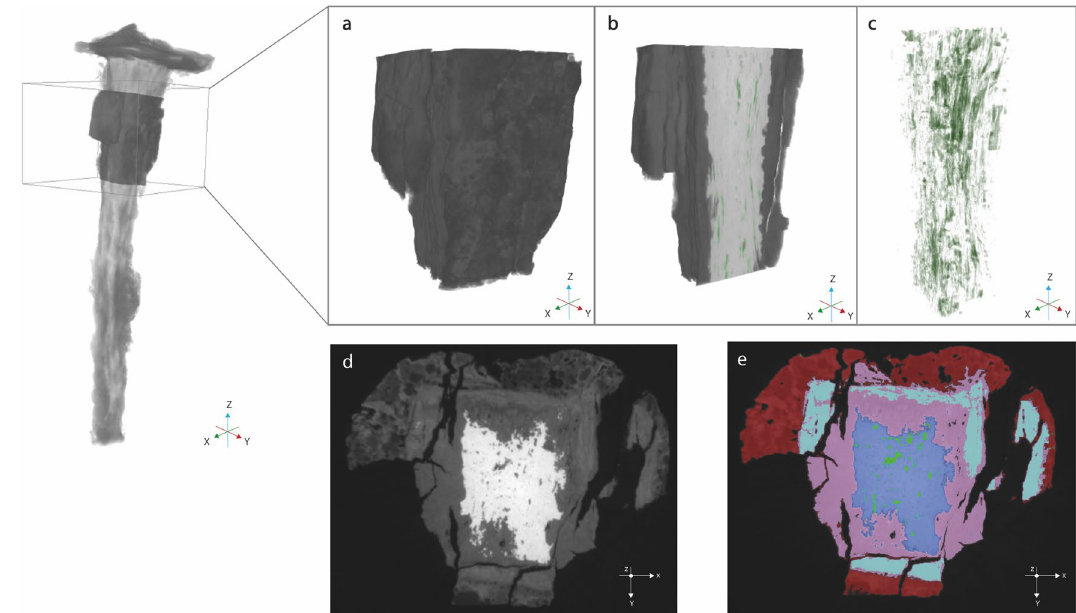
Figure 4. High-resolution scans of a selected volume of the nails. ( a ) 3D rendering of analysed section ( b ) Sagittal cut of the 3D reconstruction, showing parallel structural discontinuities ( c ) 3D segmentation of structural discontinuities (green) ( d ) 2D slice, showing microstructure detail and corrosion stratigraphy in grayscale value ( e ) Segmented 2D slice in false colors: metal in blue, DPL in pink (goethite) and turquoise (magnetite) and TM